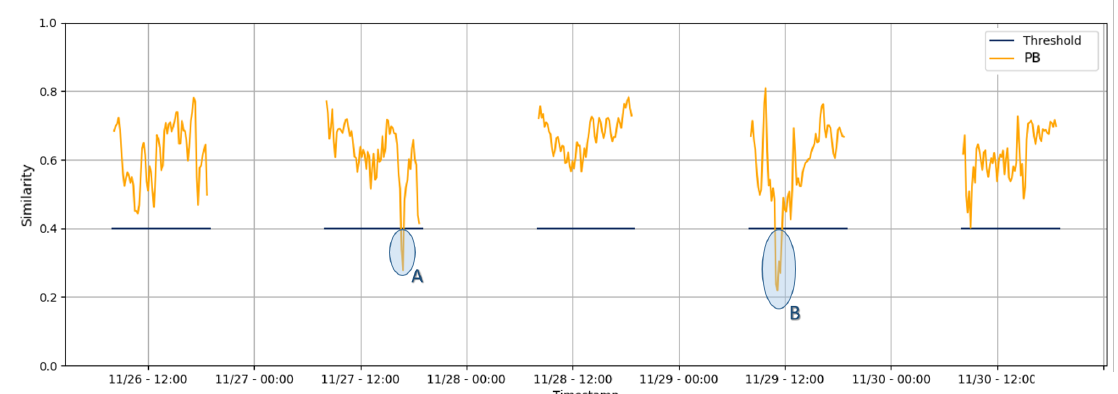
Figure 12. Predominant behavior of user C during a full work week, highlighting unexpected behavior